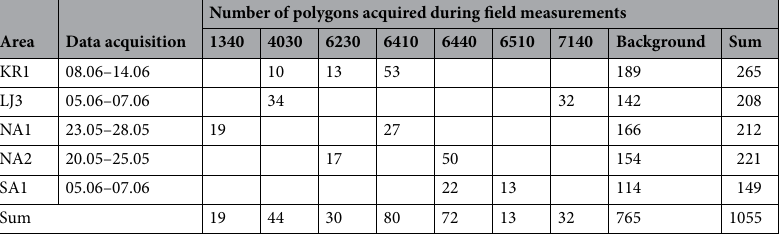
Table 2. The number and date of acquired polygons in